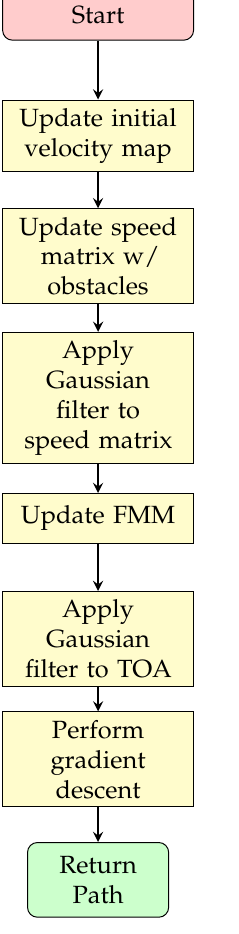
Figure 9. uFMS sequence diagram. Algorithm 9: Updating Fast Marching Square